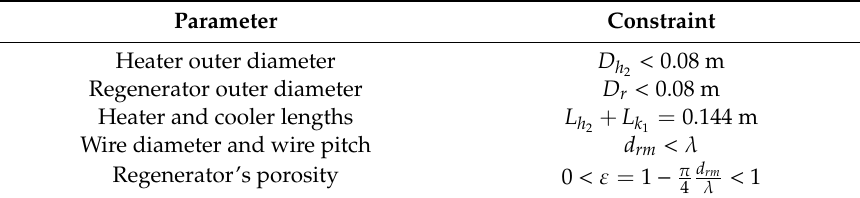
Table 5. Geometrical